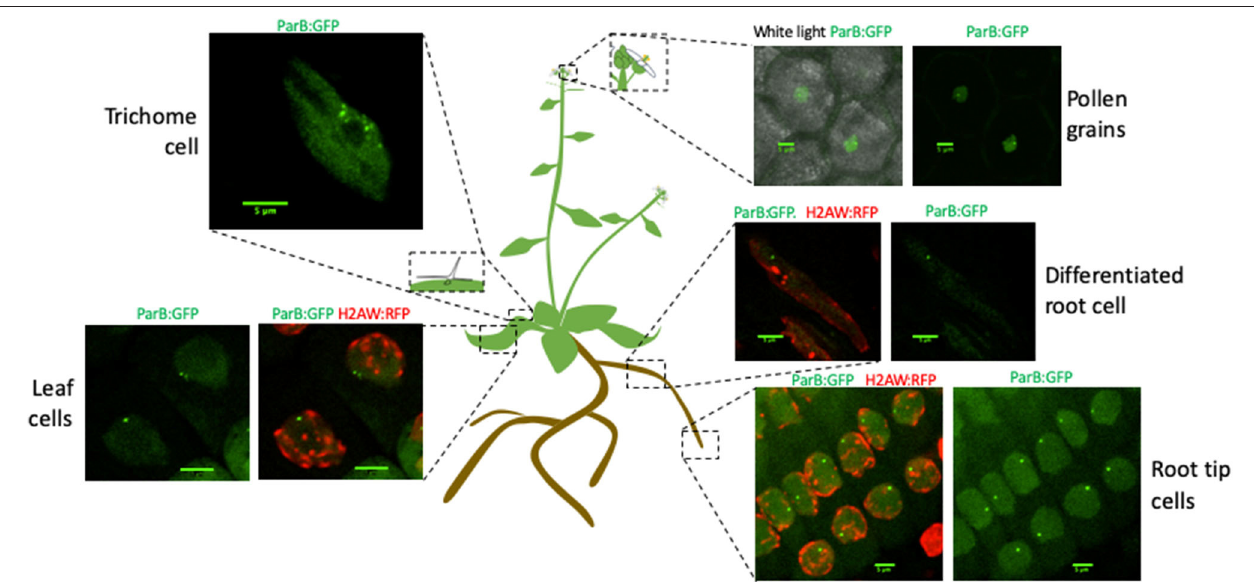
FIGURE 3 | ANCHOR system is suitable to monitor a single-copy locus in live cell and different tissues. Schematic representation of an A. thaliana plant illustrating the different tissues in which parS -ParB:GFP signals have been detected by live-cell imaging. ParB:GFP signals are shown in green and H2A.W:RFP is shown in red. Scale bars = 5 µ